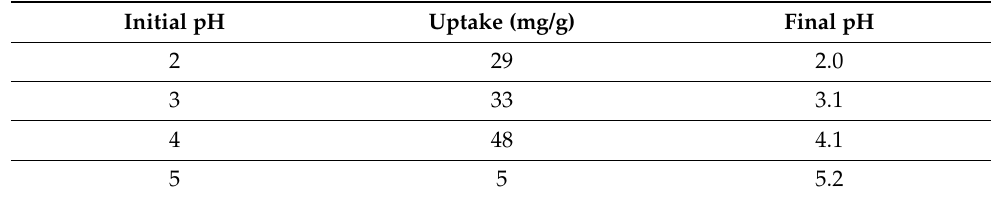
Table 1. Uptake by equilibrium dialysis dependence on pH (concentration of chitin = 2 g/L, initial concentration of Cobalt = 100 mg/L, temperature = 25 °C).